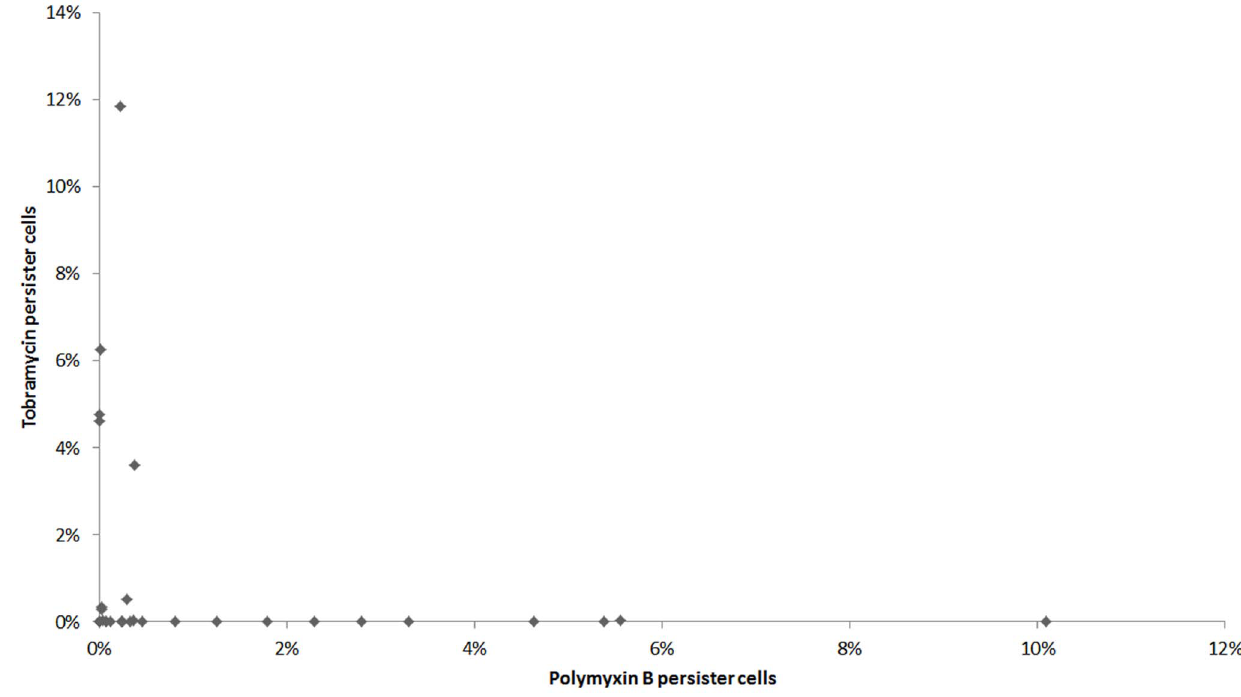
Figure 2. Correlation between polymyxin B and tobramycin persister cells in the sample population.